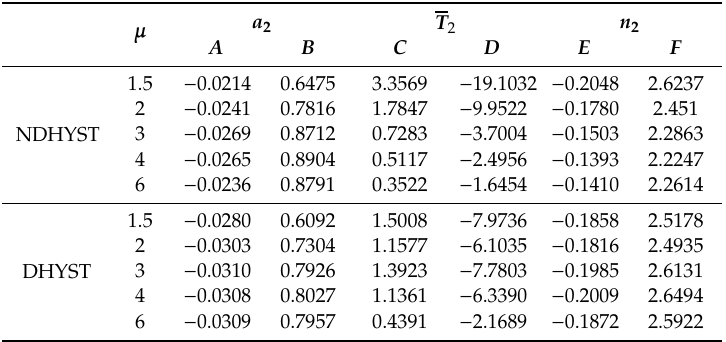
Table A1. Numerical values of the constants involved in the closed-form approximation of the mean spectrum of the hysteretic energy reduction factor R Ha (NDHYST: non-degrading hysteretic behavior; DHHYST: degrading hysteretic behavior).